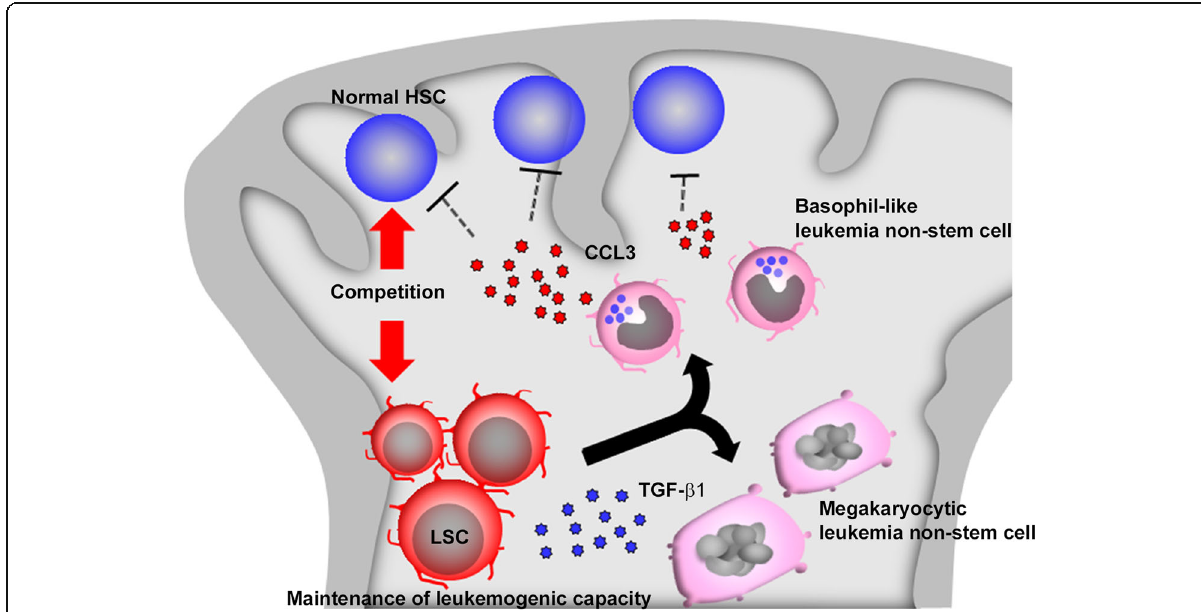
Fig. 6 Presumed roles of basophil-like and megakaryocytic leukemia non-stem cells in CML pathogenesis. LSCs massively generate basophil-like leukemia non-stem cells, which abundantly produce a chemokine, CCL3. The produced CCL3 inhibits the functions of normal HSCs which are present in a large number especially at the early phase of CML bone marrow and as a consequence, gives advantage to LSC proliferation. Concomitantly, BCR-ABL gene expression induces the appearance of senescent megakaryocytic leukemia non-stem cells in bone marrow. These megakaryocytic leukemia non-stem cells abundantly produce TGF- β 1, which can sustain leukemogenic capacity of LSCs in bone marrow, thereby promoting CML